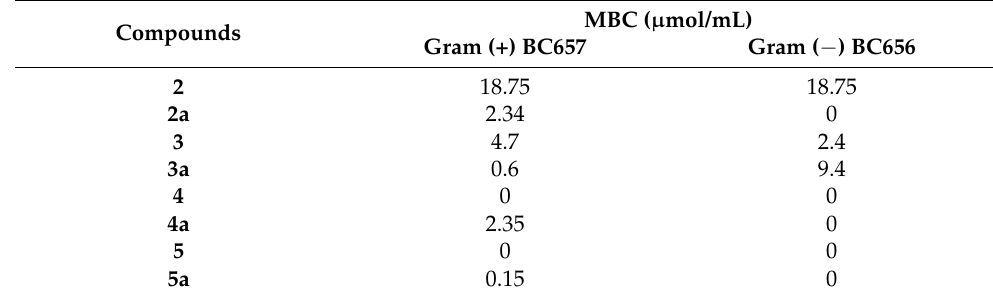
Table 1. Result of MBC determination for the Gram+ and Gram- strains.